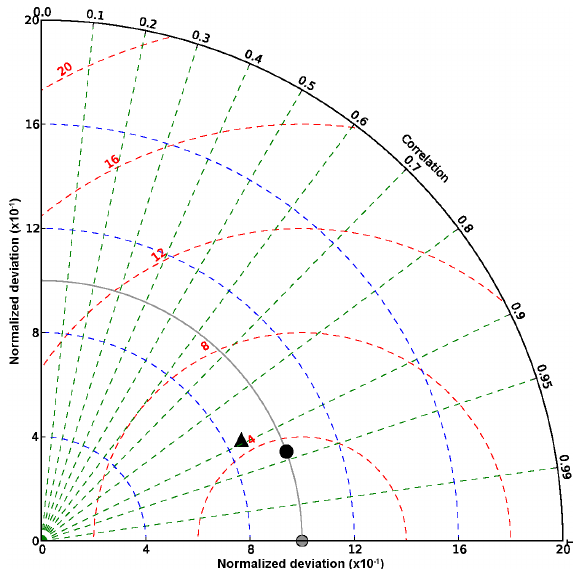
Figure 13. Taylor diagram of the comparison of the sum of GRACE ocean mass and the steric Argo DHAs with a reference level at 900dbar (triangle) and 1900dbar (circle) with altimeter sea level time series (SSALTO/DUACS, 2014) (gray reference circle) on the x axis over 2005–2013. The blue dotted lines indicate the normal- ized standard deviation (altimetry being the